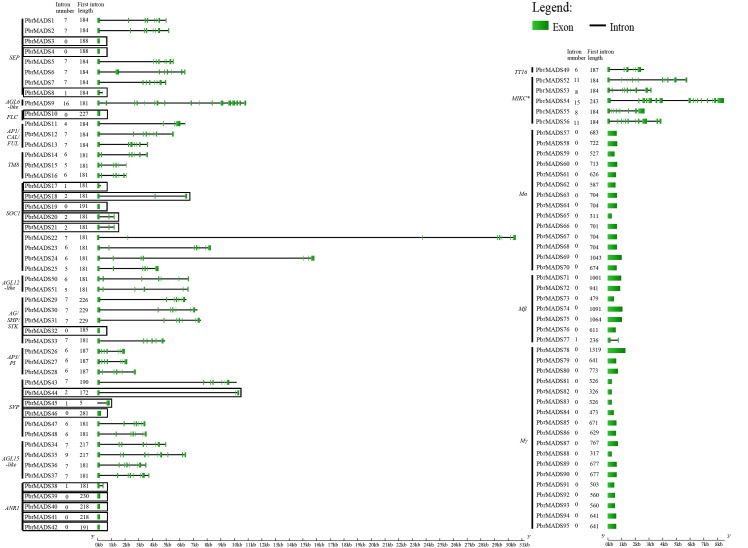
Gene structure analysis of MADS-box transcription factors in pear.Exons are represented by green boxes, and introns by black lines. Each gene is shown proportionally using lengths of exons and introns. Non-K domain genes are marked with black boxes. Intron number and first exon length of each gene are indicated following gene name.